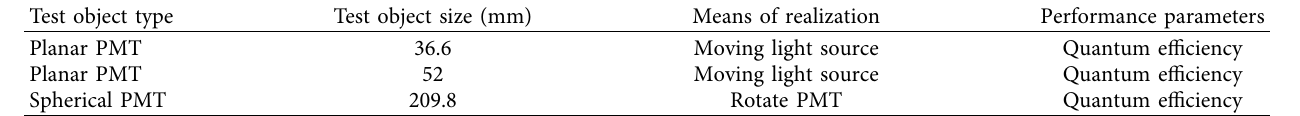
Table 2: Comparison of the equilibrium monitoring system of photoelectric devices.